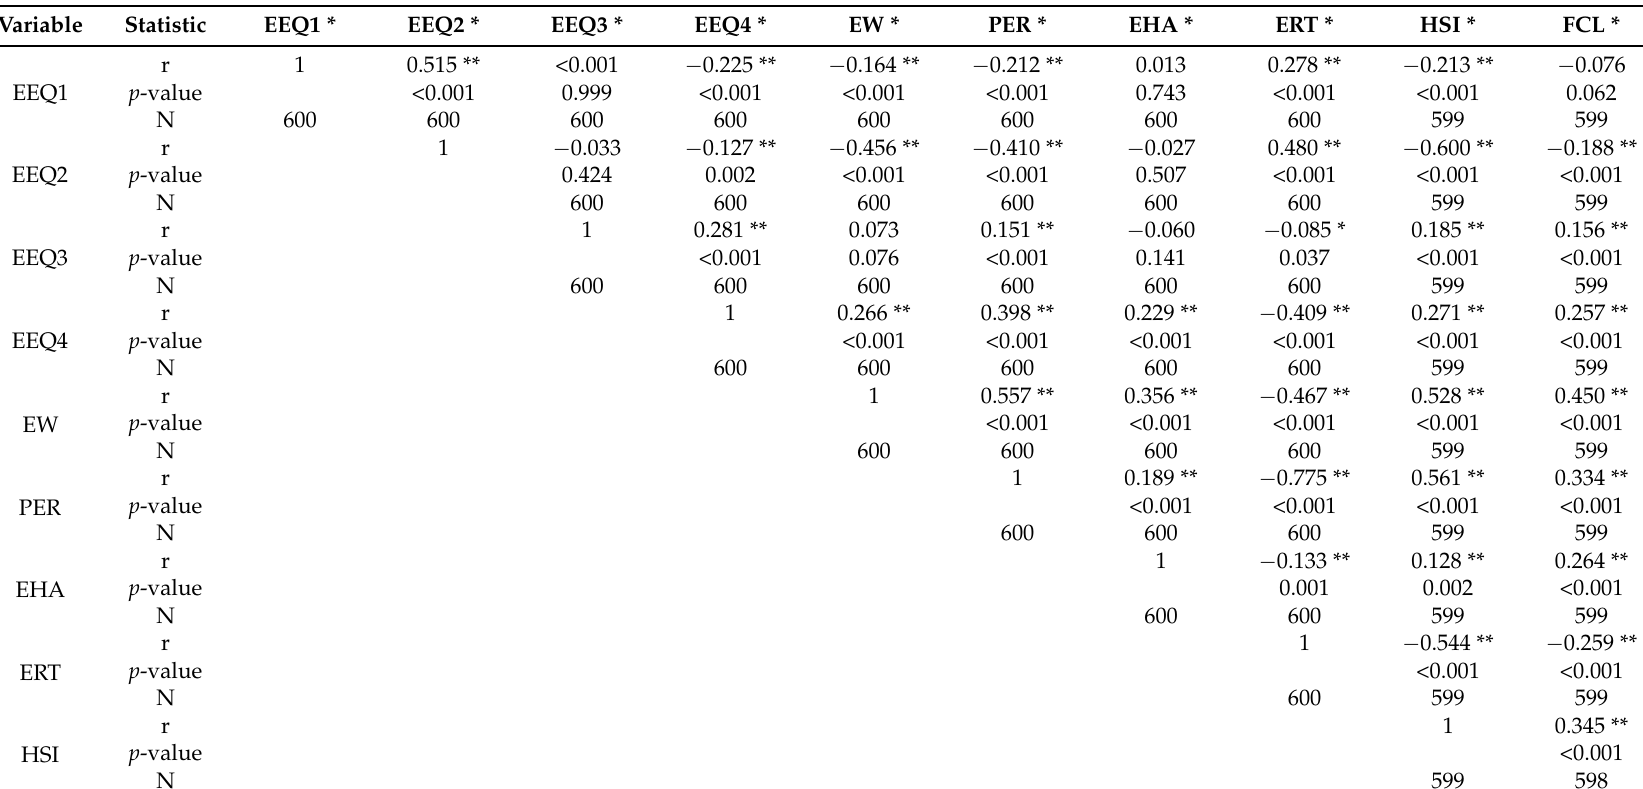
Table 3. Correlation of subjective measures of oil exposure with explanatory factors and health outcome